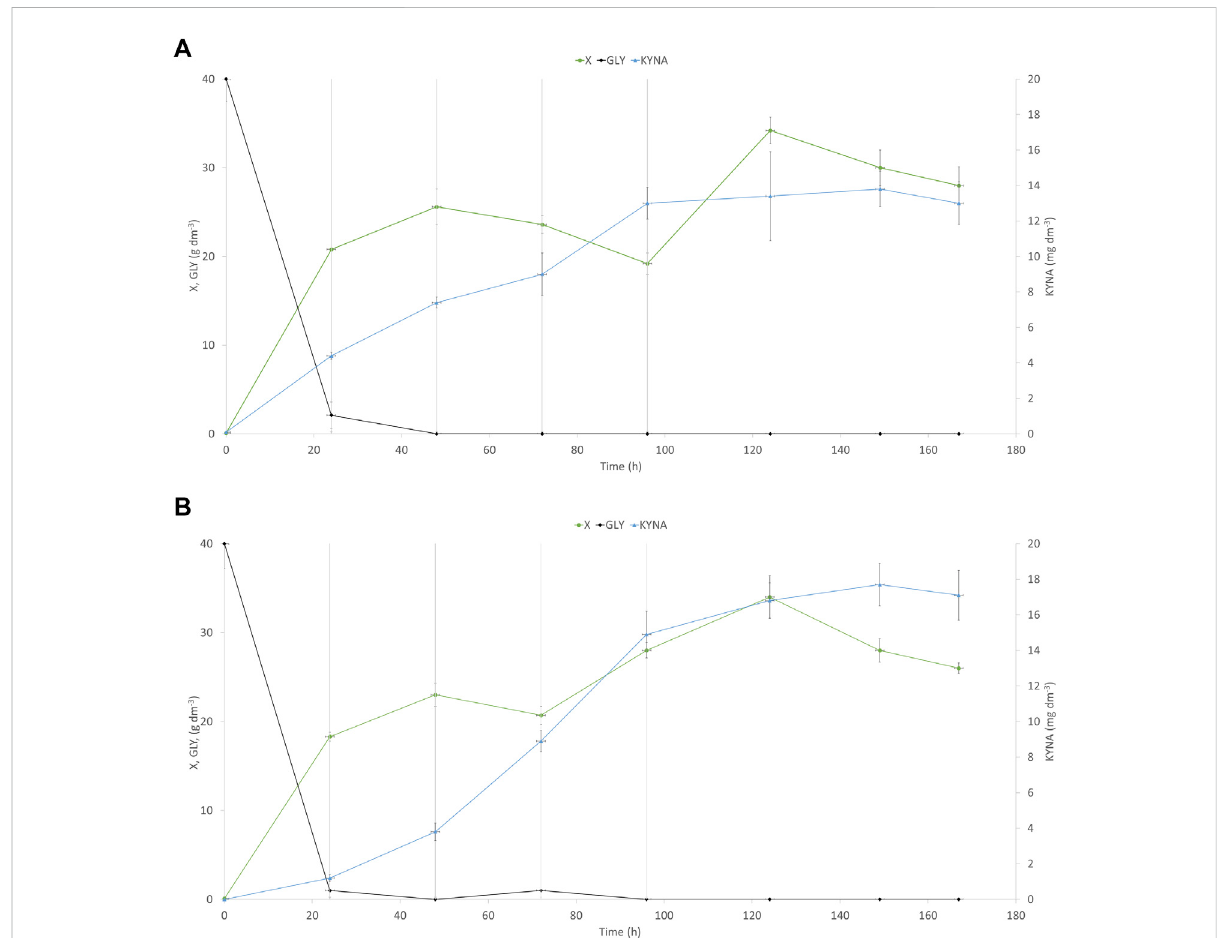
FIGURE 5 Kinetics of yeast growth ( C ), glycerol consumption ( ◆ ), and kynurenic acid production ( ▲ ) of the Y. lipolytica A-101.1.31 strain (A) and mutant strain of Y. lipolytica A-101.1.31 GUT 1/1 (B) growing on waste glycerol and soybean molasses added in four portions (indicated as gray vertical lines). X-biomass; GLY-glycerol; KYNA-kynurenic